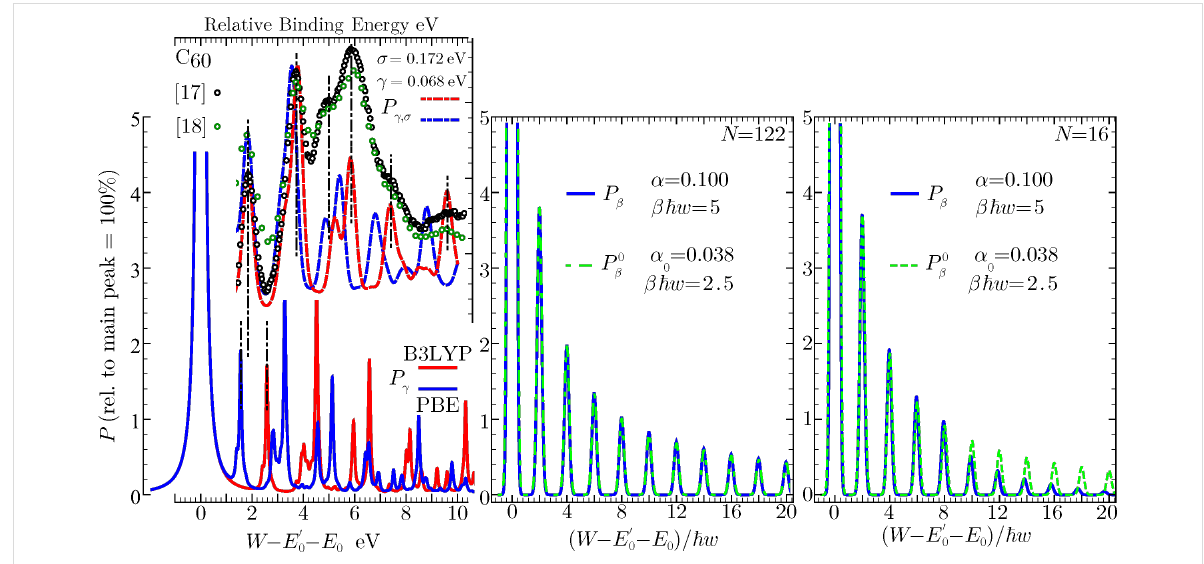
Figure 6: Low-temperature work distributions for: (left) a C 60 molecule undergoing core-ionization; (center,right) a Fermi gas of N = 16, 122 particles shaken-up by a perturbation of critical index α = 0.1. In the C 60 case, P γ is the zero-temperature distribution broadened by a Lorentzian of width γ = 0.05 eV; P γ , σ is obtained by convoluting P ( W ) with a Voigt distribution [18,19], whose Gaussian standard deviation σ = 0.172 eV and Lorentzian width γ = 0.068 eV are adjusted to some measurements on thick fullerene films. The experimental data are taken from [12,13] and plotted on the same arbitrary unit scale [18,19]. The theoretical distributions are computed with the DFT approach outlined in Section 2.1, using both the PBE and the B3LYP functionals. In the two examples of the Fermi gas, the zero-temperature work distributions are broadened with a Gaussian whose standard deviation δ β corresponds to , and compared with the analytical model of [32,35]. Vertical values are given in percent relative to the no-shake